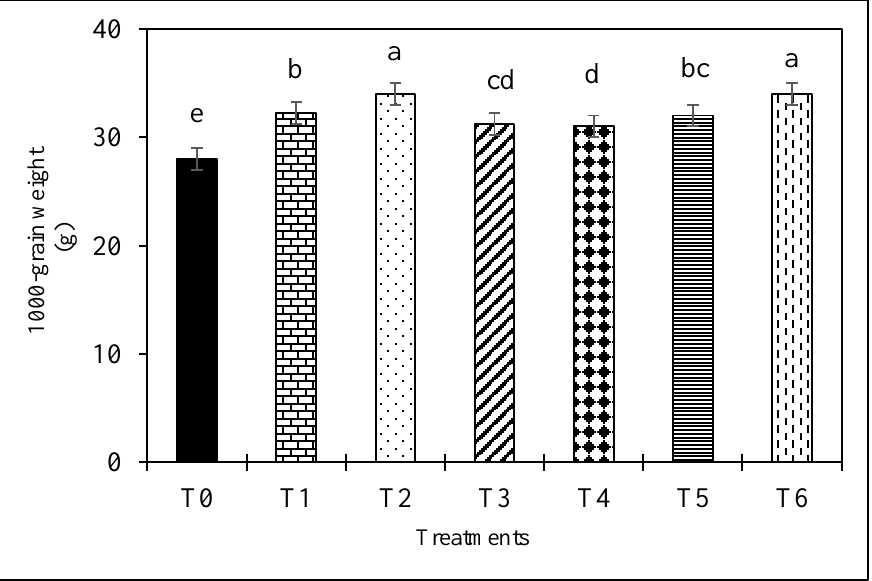
Figure 3. Effect of different N fertilizer and their combinations on one thousand grain weight; mean of 4 replicates. Different letters indicate statistical differences ( p < 0.05), T0: no fertilizer, T1: 100% urea, T2: 100% beef cattle manure, T3: 100% poultry litter, T4: 50% urea + 50% beef cattle manure, T5: 50% urea + 50% poultry litter and T6: 40% urea + 30% beef cattle manure + 30% poultry